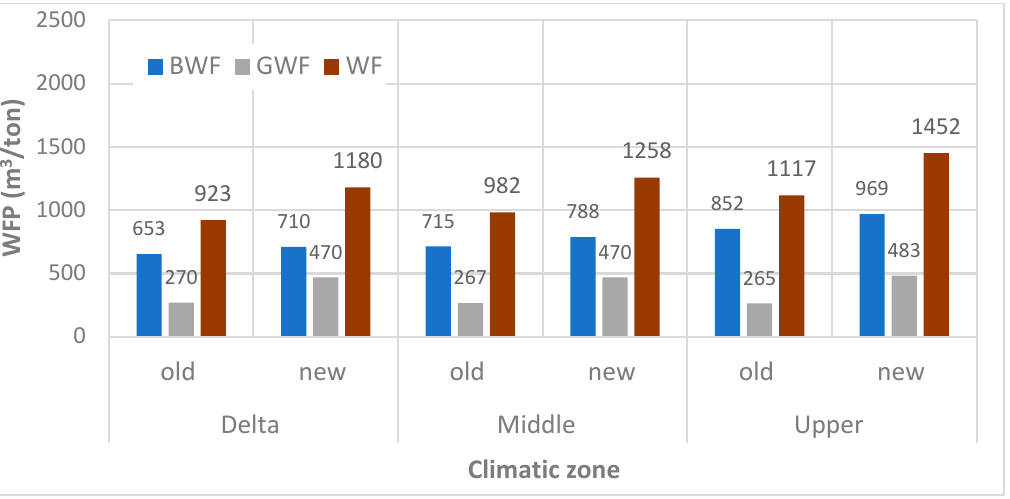
Figure 7. Blue, grey, and total water footprints for wheat for three agro-ecological zones and two soil types, i.e., old and new land.